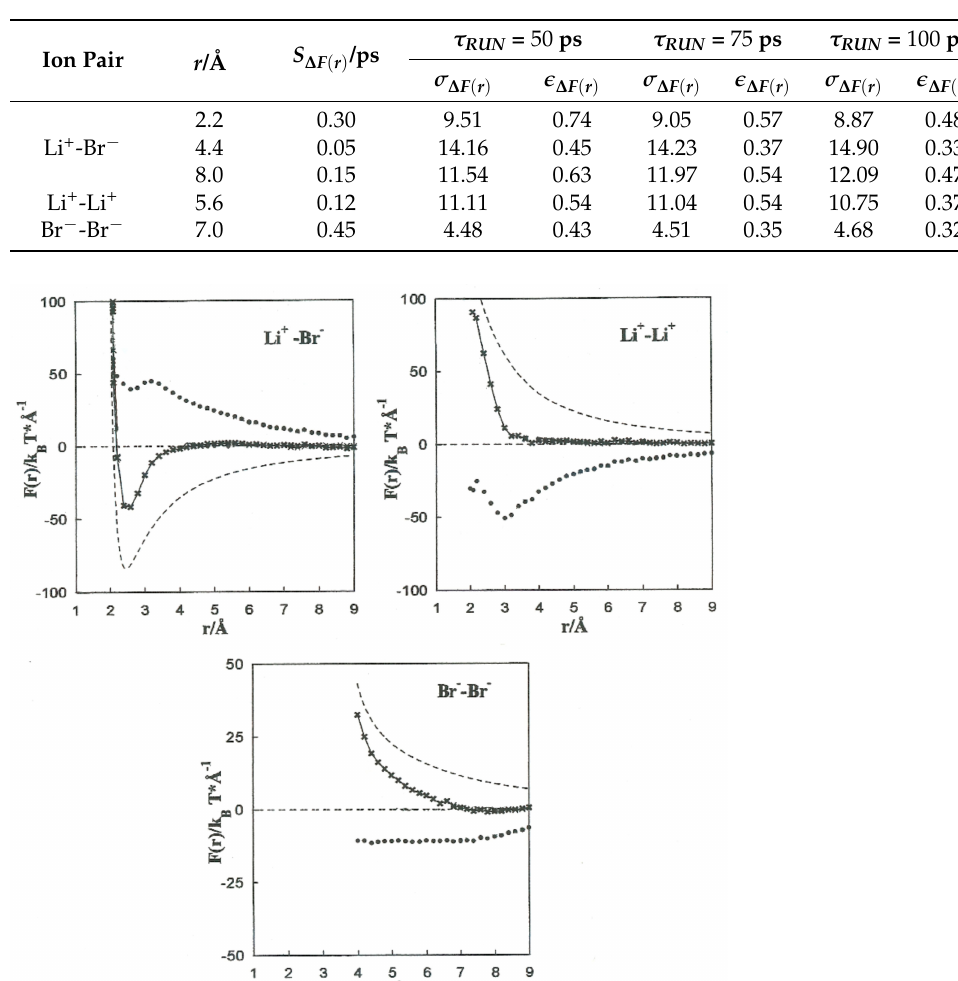
Figure 5 shows the PMF values for the various ion pairs. Oscillations in the potential corresponding to Li + -Br − occur in association with the structure of the solvent in the vicinity of the ions. W(r) shows a noticeable minimum at 2.2 Å and lower one at 8.0 Å. The contact ion pair (CIP) region corresponding to the first minimum, and for the solvent separated ion pair (SSIP) region the second one. W(r) shows a maximum at r = 4.4 Å. In the CIP region, the ion pairs are enclosed by acetonitrile particles, with the corresponding nitrogen atoms geared to the Li + and their methyl groups in the direction of Br − , as illustrated in Figure 6. The SSIP region values are attributed to attractive forces produced by solvent molecules between ion